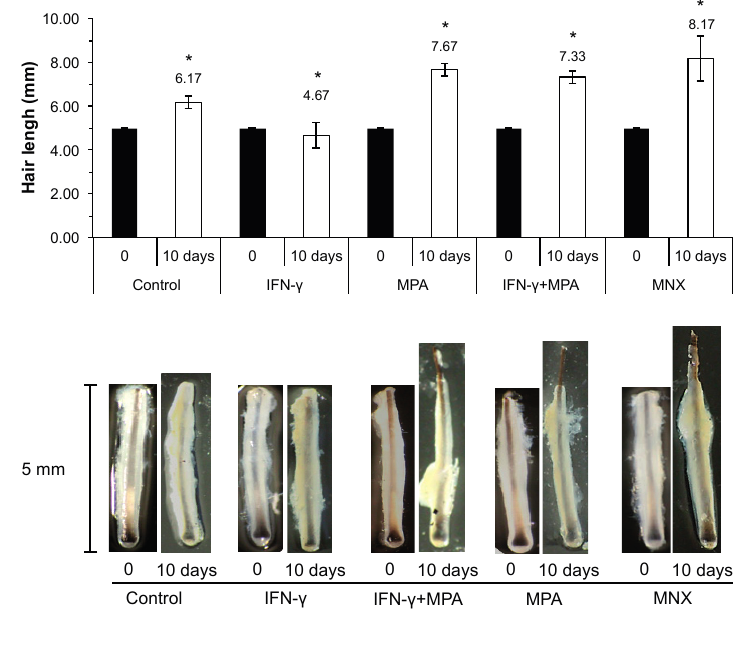
Figure 6. MPA stimulates growth IFN- γ -treated hair follicles in organ culture. A total of 350 human scalp hair follicles with intact dermal papillae were obtained and treated for 10 days with IFN- γ (100 ng/mL), MPA (100 nM), or both IFN- γ and MPA. The length of each hair follicle was measured under a microscope on days 0 and 10. The relative length of each hair shaft is shown as mean ± SD ( upper panel ). Images of representative hair follicles at days 0 and 10 are shown in the lower panel . MNX (1 µM) served as positive controls for stimulation of hair follicle growth. All values were expressed as mean ± SD. Statistically significant differences were determined by ANOVA ( * p <